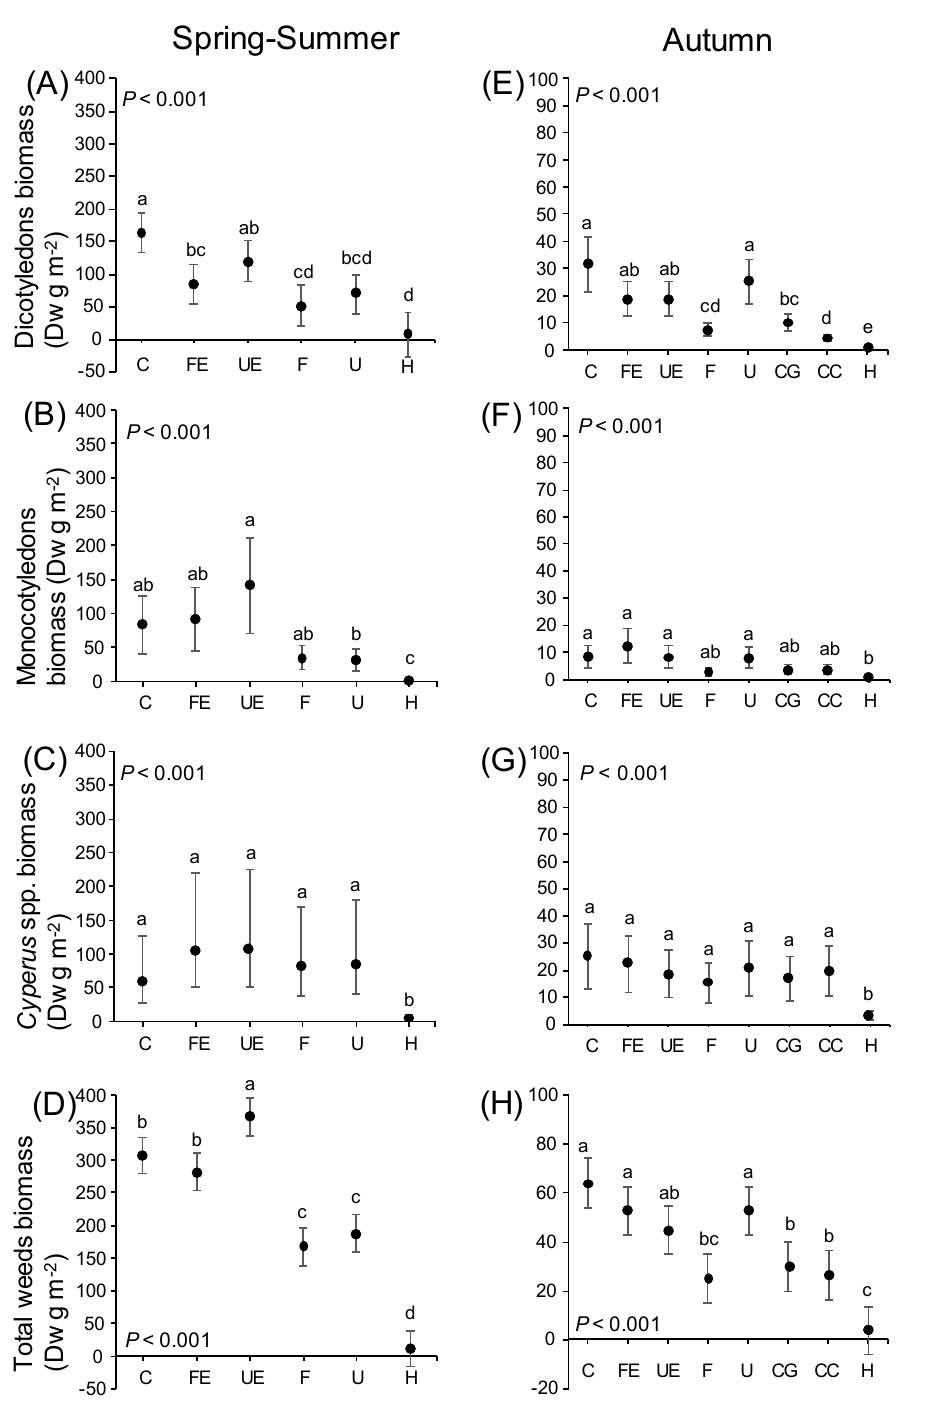
Figure 1. Effect of waste treatments on the biomass of dicotyledon weeds ( A , E ); monocotyledon weeds ( B , F ); the weed Cyperus spp. ( C , G ); and total weeds ( D , H ) emerged from pots filled with agricultural soil and placed outdoors in Spring–Summer (Experiment 1, 2019) and Autumn (Experiment 2, 2019). C = control, FE = Vicia faba pod extract, UE = Urtica dioica extract, F = Vicia faba pod waste, U = Urtica dioica waste, CG = spent coffee grounds waste, CC = corn cobs waste, H = positive control with herbicide. Dw = dry weight. Figures show least-square mean values (± confidence intervals). n = 5. For Cyperus spp. biomass in Spring–Summer, confidence intervals were back-transformed from the log scale. Different letters indicate statistical significance according to the lsmeans function at p ≤